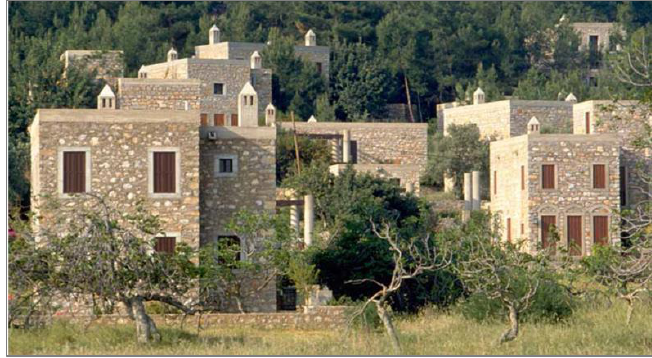
Figure 15 Turgut Cansever, Demir Vacation Village (URL-7)